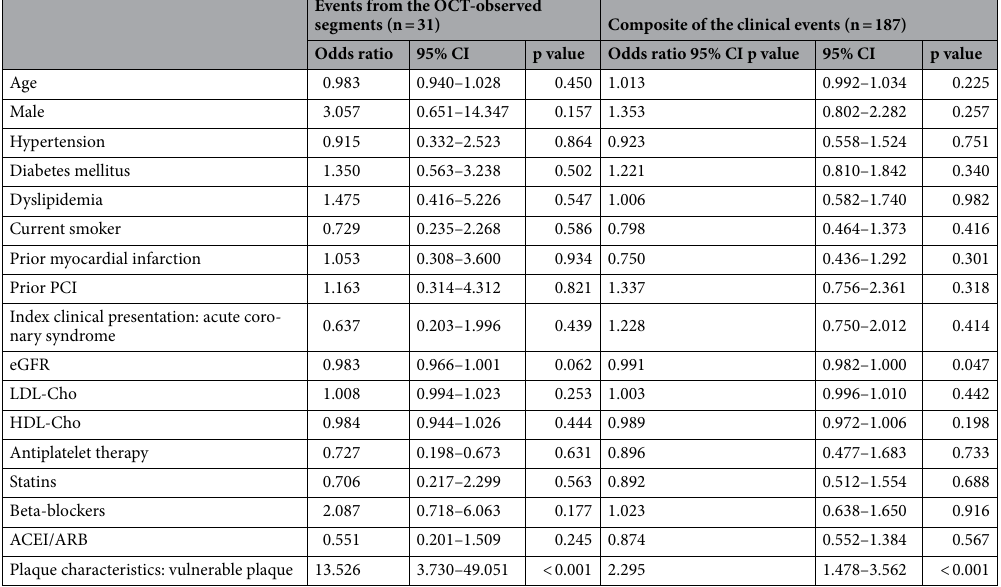
Plaque characteristics: vulnerable plaque Table 2. Events from the OCT-observed segments and the composite of clinical events. CI confidence interval, PCI percutaneous coronary intervention, eGFR estimated glomerular filtration rate, LDL-Cho low-density lipoprotein cholesterol, HDL-Cho high-density lipoprotein-cholesterol, ACEI angiotensin-converting enzyme inhibitor, ARB angiotensin II receptor blocker.